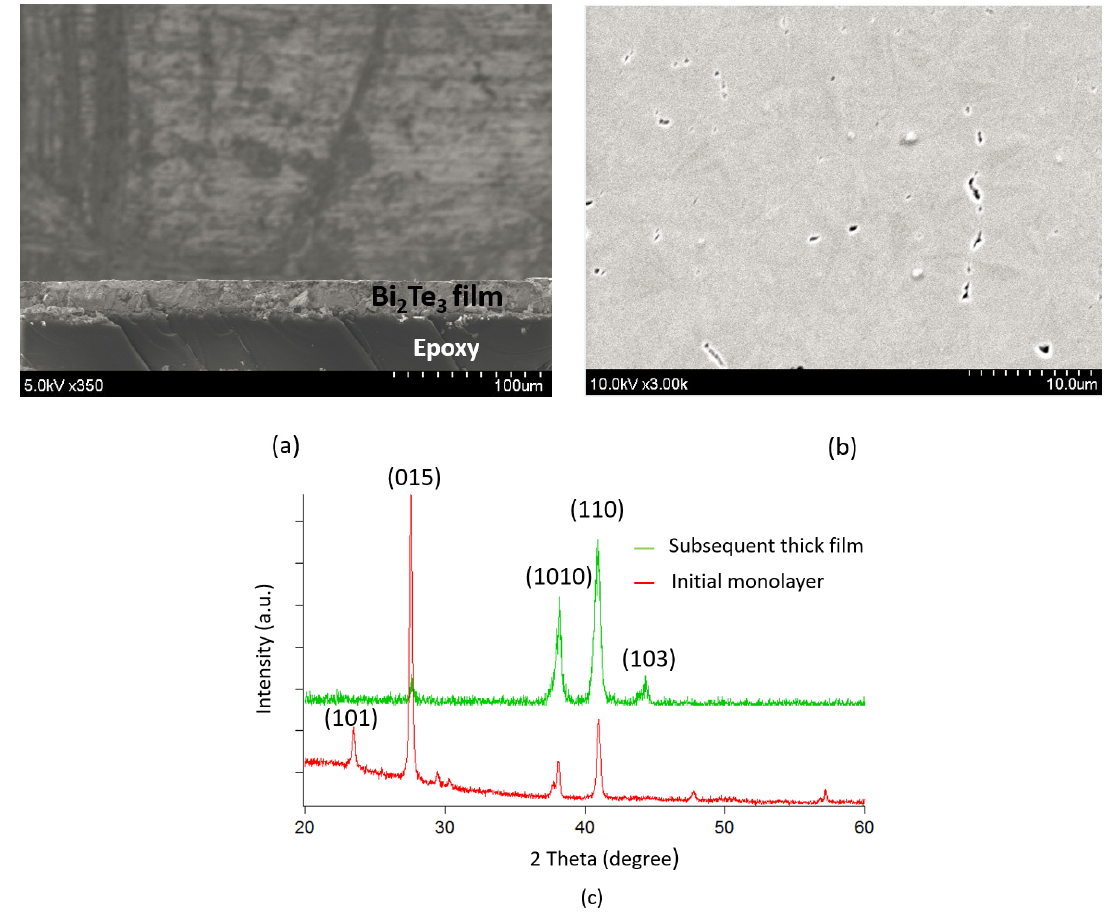
Figure 6. The dependence of the metallic seed layer on the lattice matching of the initial monolayer: ( a ) sample structure after being separated from the metallic seed layer with the monolayer on the top surface; ( b ) surface morphology determined via Scanning Electron Microscopy (SEM) observation; and ( c ) XRD pattern of the initial monolayer.